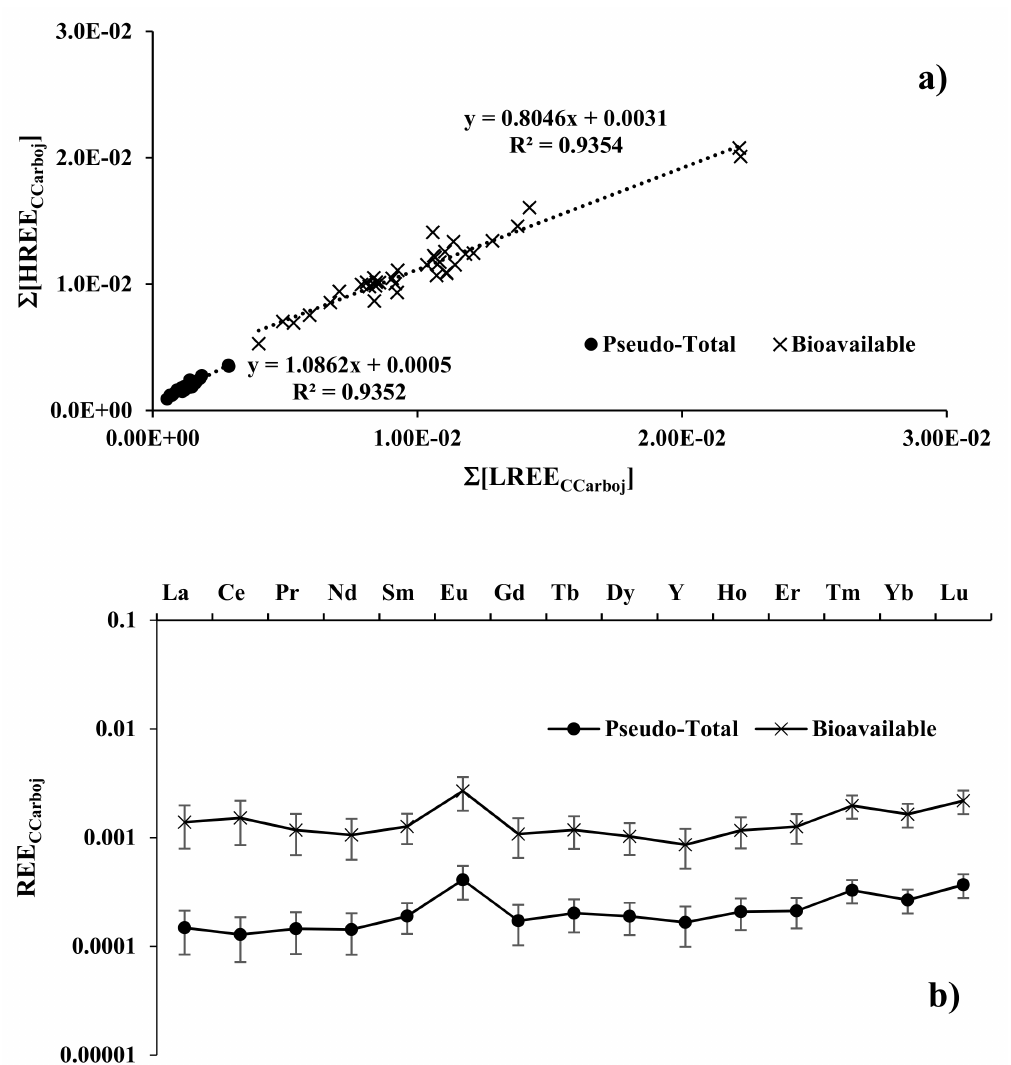
Figure 4. ( a ) ∑ [HREE CCarboj ] vs. ∑ [LREE CCarboj ] relation for all olive pulp samples. ( b ) Pseudo-total and Bioavailability Campo Carboj-normalised REE patterns (K d ) of investigated olive oil